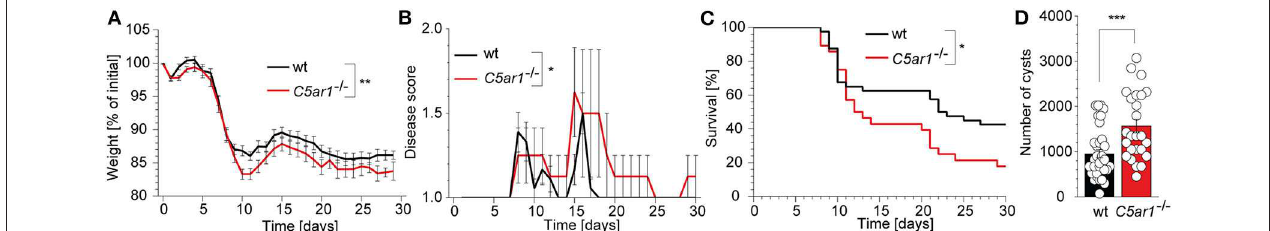
FIGURE 1 | Impact of C5aR1 activation on weight loss, disease severity, survival, and parasite burden in the brain after i.p. T. gondii infection. Wt and C5ar1 − / − mice were infected i.p with 50 cysts of T. gondii type II strain ME49 and monitored for 30 days. (A) Relative weight change in infected wt ( n = 30) and C5ar1 − / − mice ( n = 23). (B) Change of disease score during the course of infection (wt n = 18, C5ar1 − / − n = 9). (C) Survival of wt and C5ar1 − / − mice post-infection. Statistical differences in survival between wt ( n = 40) and C5ar1 − / − ( n = 28) mice were calculated using the Log-rank Mantel-Cox test. (D) Cyst count in brain tissues 30 days after infection in surviving wt and C5ar1 − / − mice as counted in the brain homogenate using light microscopy (wt n = 35, C5ar1 − / − n = 25). Values shown in (A,B,D) are the mean ± SEM; differences between groups were compared by unpaired t -test, * p < 0.05, ** p < 0.01, *** p < 0.001.